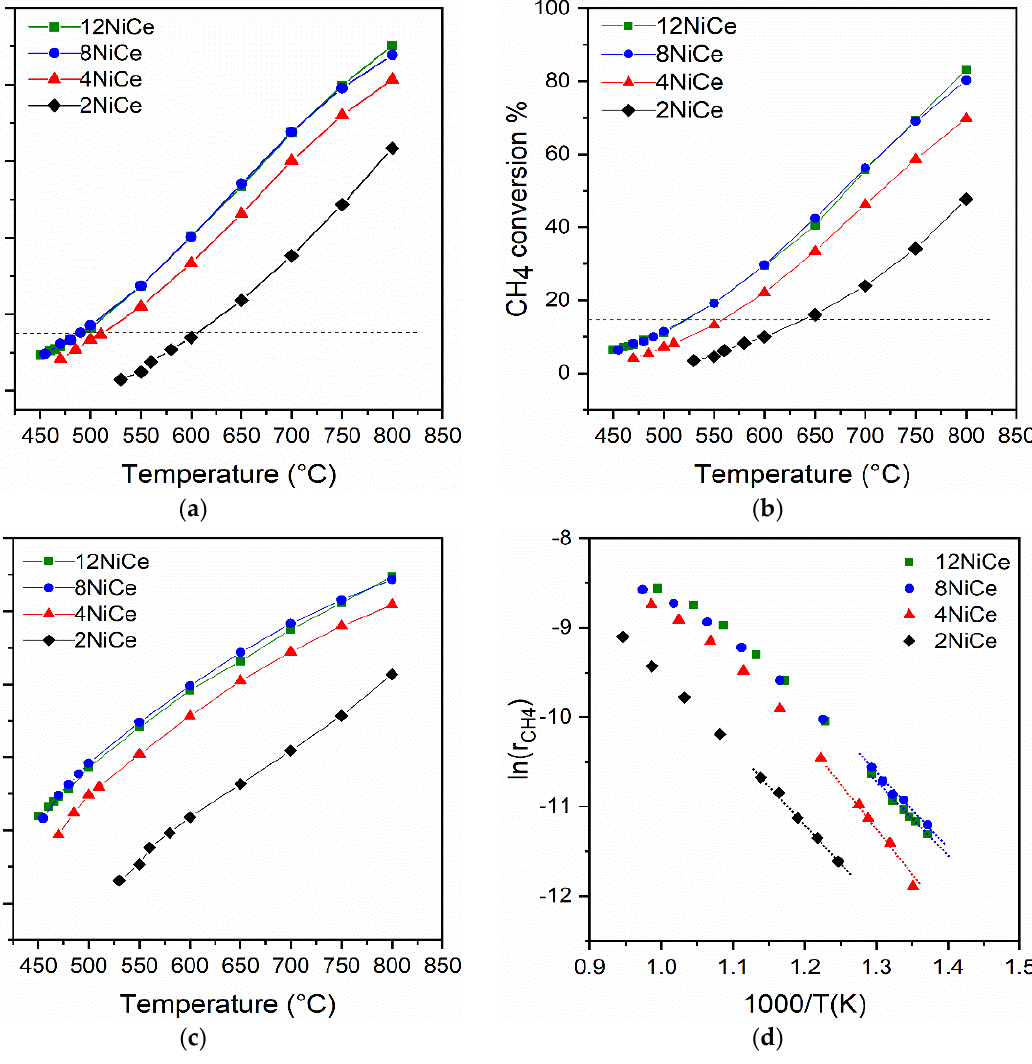
Figure 7. Comparison of the catalytic properties of Ni/CeO 2 catalysts with different nickel contents: ( a ) CO 2 conversion, ( b ) CH 4 conversion, and ( c ) H 2 /CO ratio: points below the dotted line (<15% conversion) are used to calculate the slope in the Arrhenius plot; ( d ) Arrhenius plot: ln(r CH4 ) as a function of the inverse of the absolute temperature.